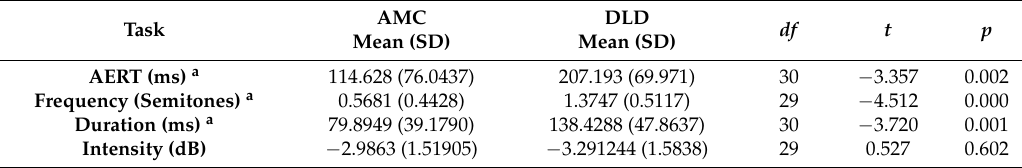
Table 5. Results of t -tests by group for auditory threshold (AT) tasks.